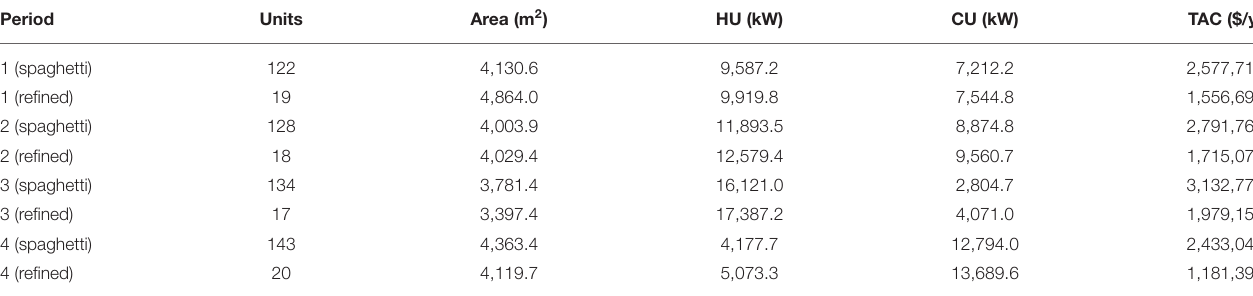
TABLE 2 | Individual period solutions data.